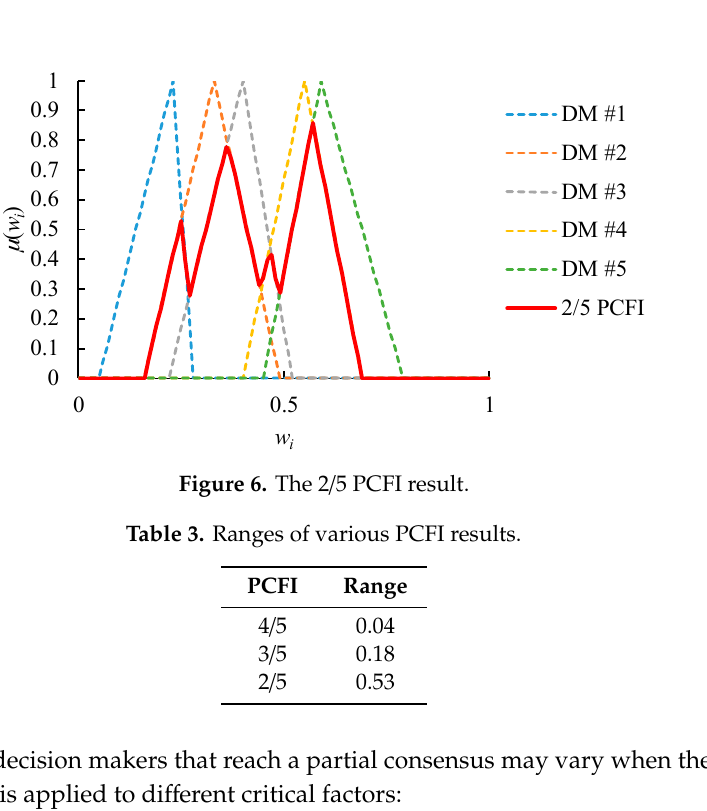
Table 3. Ranges of various PCFI results.